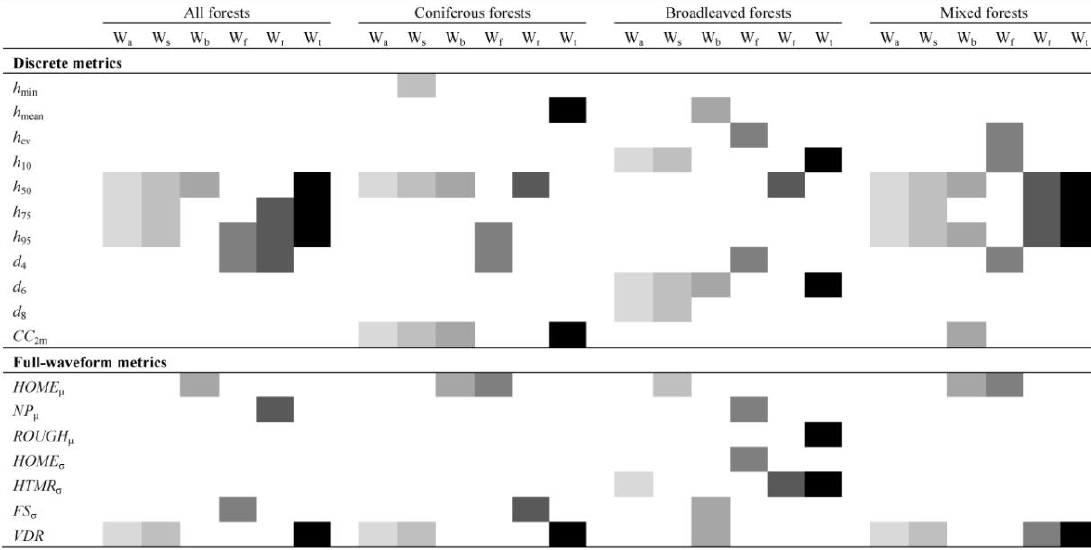
Figure 7. The selected LiDAR metrics of the combo model in various forest